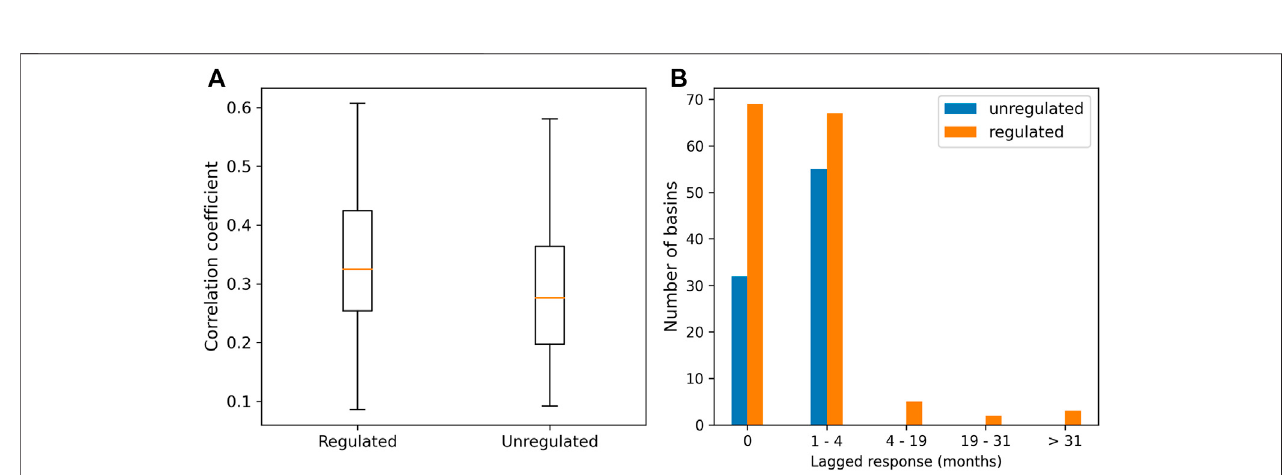
FIGURE 9 | Maximum cross correlation coef fi cient distributions (A) and signi fi cant lagged response categories [months; (B) ] between 3-month SPEI and 3-month SRI for regulated and unregulated basins.